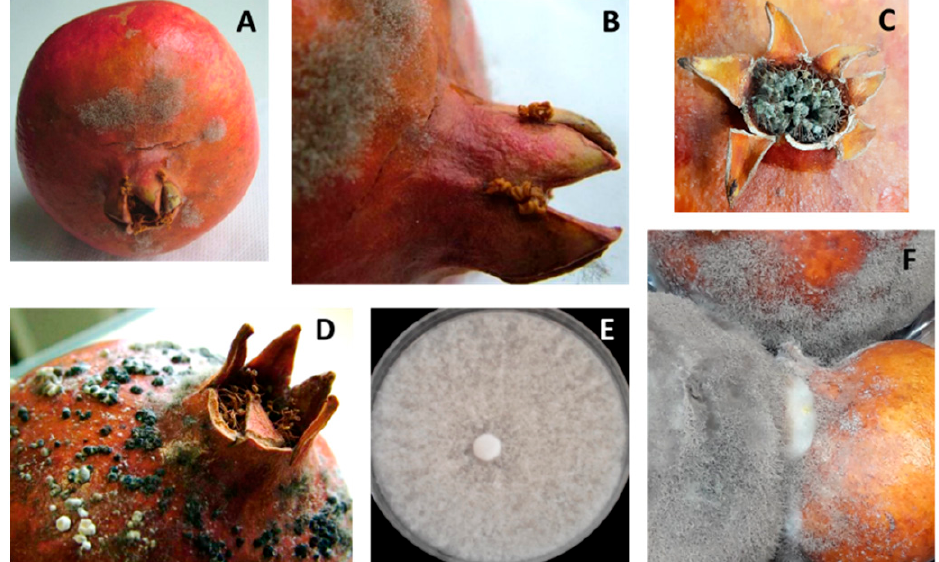
Figure 1. Gray mold caused by Botrytis cinerea . ( A ) Early stage of rot. ( B ) Close-up image of sporulated gray mycelia, ( C ) infected stamens and ( D ) black sclerotia. ( E ) B. cinerea young colony on PDA. ( F ) Nesting secondary infection between fruits.